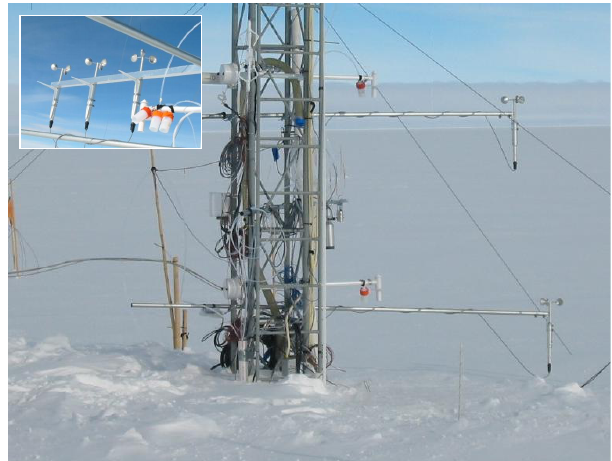
Photograph showing the setup of the ozone flux gradient experiment on the Summit flux tower. The picture depicts the two lowest measurement heights only. Instruments are pointing towards the south, the dominating wind direction at Summit. Each gradient height measurement consists of a wind speed measurement (located furthest to the right in the picture, supported by the cross arm, a temperature measurement, with a downwards pointing inlet from the aspirator, and an ozone inlet funnel (in orange). The insert in the upper left corner shows the cup anemometer and ozone inlet arrangement during an inter-comparison experiment.